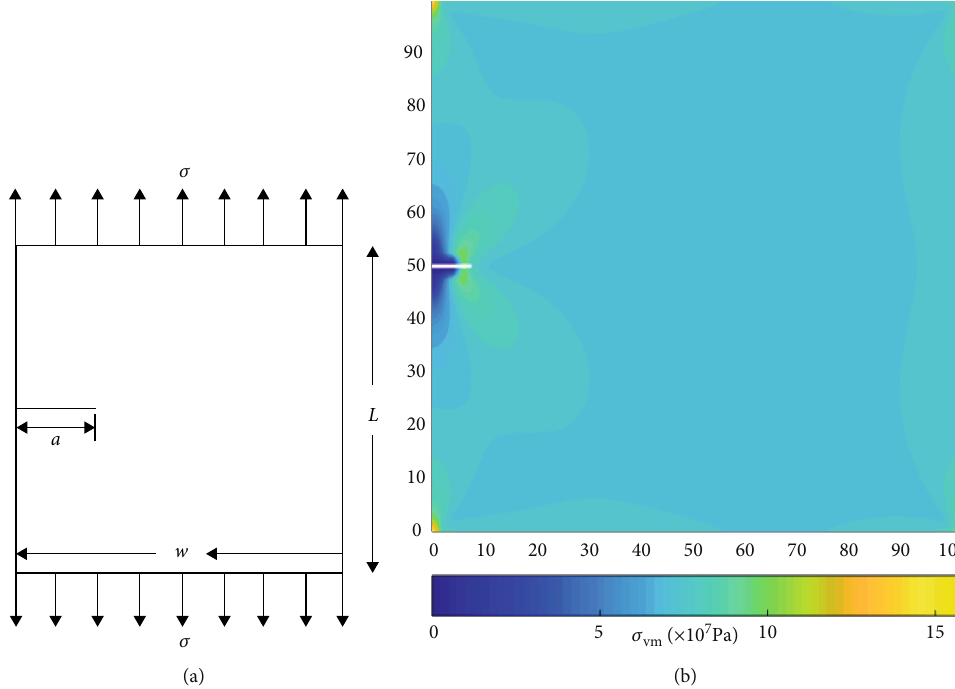
Figure 4: Single edge crack: (a) schematic of a w × L plate with an a -long horizontal edge crack and loaded by vertical tractions σ ; (b) shaded plot of the von Mises stress σ vm for a 100 × 100 m 2 plate mesh and a = 7 : 5